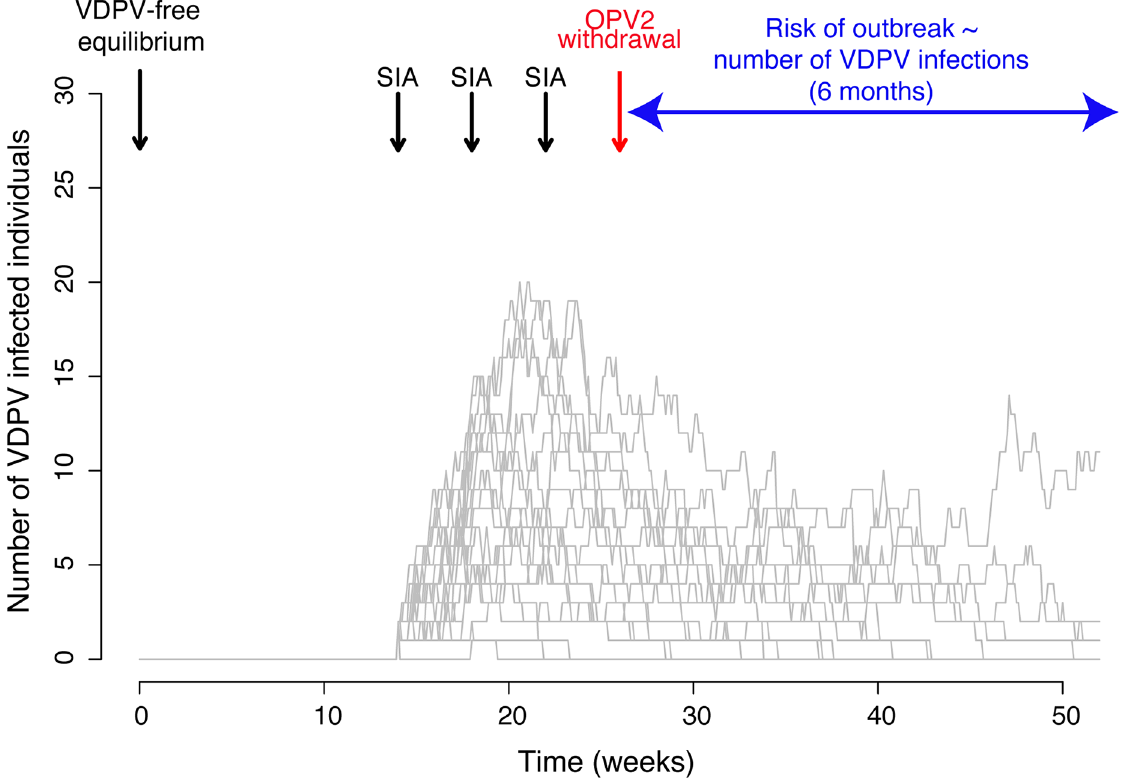
Fig 1. Illustration of results from the stochastic dynamic mathematical model of VDPV2 emergence and spread. The model is simulated for 1 year and a population of 10,000 individuals, starting from a VDPV-free equilibrium that includes routine immunisation. OPV2 withdrawal occurs at 6 months (red arrow) and the last tOPV SIA is assumed to occur 4 weeks before this date in agreement with current plans. SIAs are implemented 4 weeks apart. We define the risk of a VDPV2 outbreak after OPV2 withdrawal as the probability of having > 200 incident VDPV2 infections during the 6 months following OPV2 cessation. In this illustration, the grey lines represent the number of VDPV infected individuals over time for 20 different simulations of the model assuming 20% routine immunisation coverage and 3 tOPV SIAs with 80% coverage implemented before OPV2